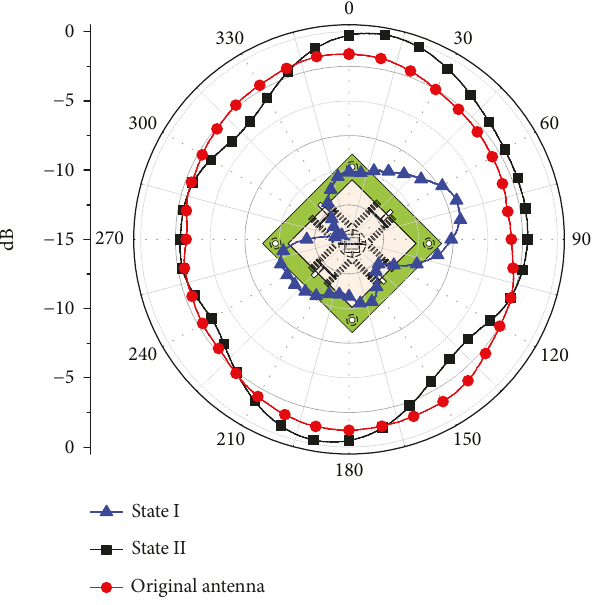
Figure 6: The H-plane pattern of state I (blue trace), state II (black trace), and the original antenna (red trace) at